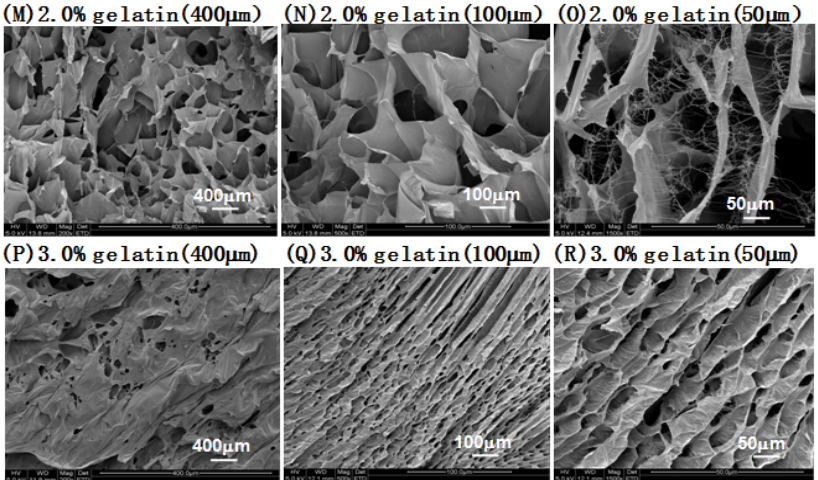
Figure 3. SEM images of sustained-release preparations based on different gelatin concentrations. ( A – D ) SEM images of sustained-release preparations based on different gelatin concentrations. After lyophilization, the microstructures of the gel were cut into longitudinal sections and visualized using scanning electron microscopy (SEM). The SEM of ( A – F ) 0.1% and 0.5% gelatin (longitudinal), ( G – L ) 1.0% and 1.5% gelatin (longitudinal), and ( M – R ) 2.0% and 3.0% gelatin (longitudinal) prepara- tions are shown. Scale bar = 400 µ m for A, D, G, J, M, and P; 100 µ m for B, E, H, K, N, and Q; and 50 µ m for C, F, I, L, O, and